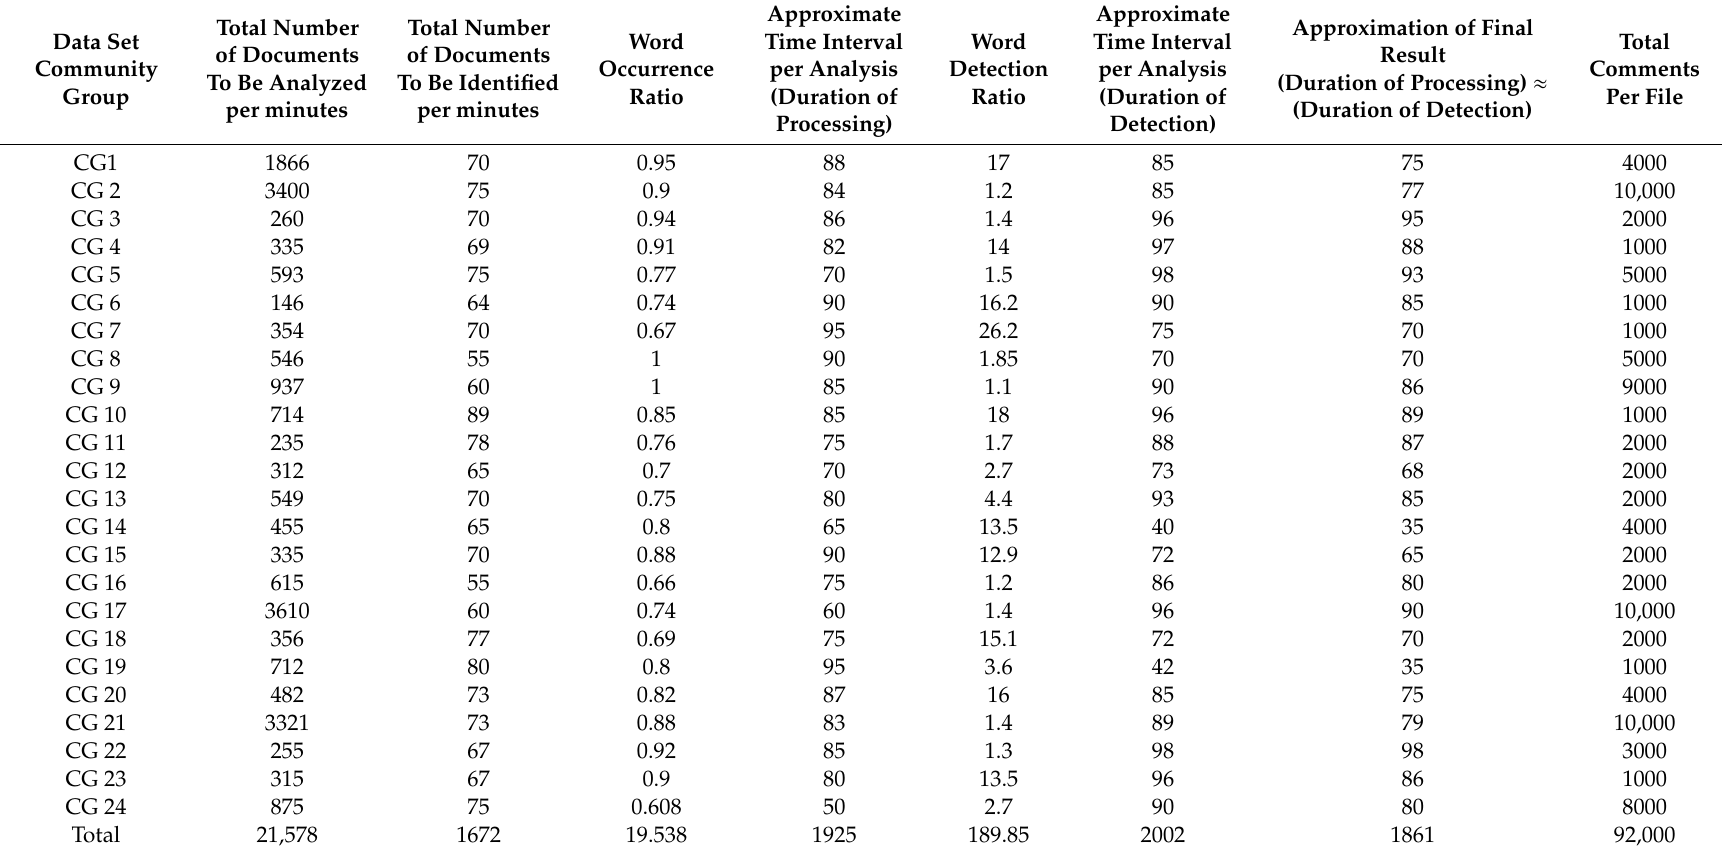
Table 1. Word detection and mapping various data community